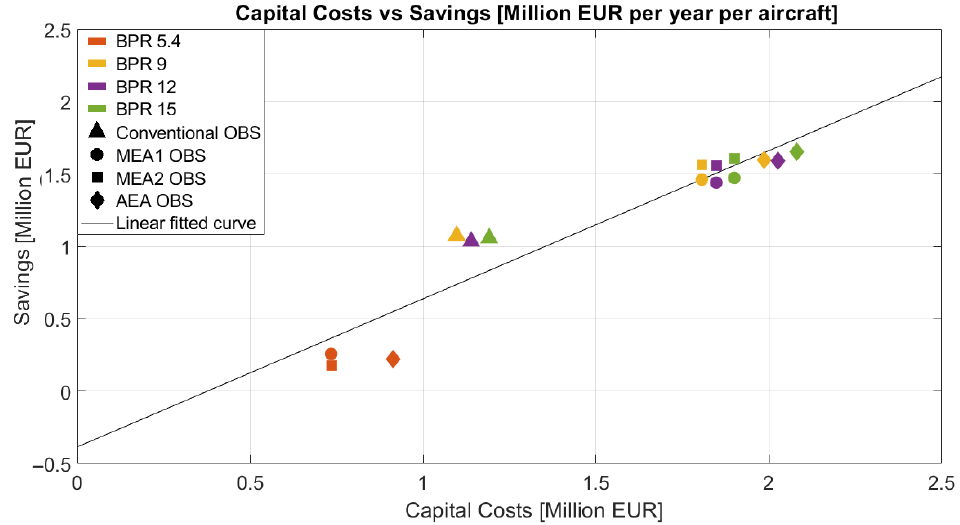
Figure 15. Capital costs and savings, represented for all the retrofitting solutions considered. The